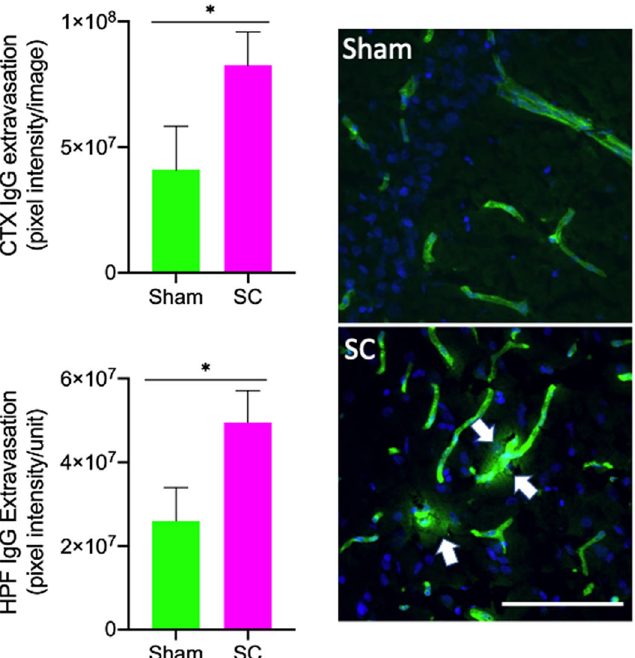
Figure 3. BBB permeability. The integrity of BBB was assessed with immunofluorescent microscopy measuring the parenchymal perivascular extravasation of IgG in rats that received either sham or repeated sub-concussion (SC) procedure for 2 weeks. The IgG extravasation was semi-quantitatively determined in the cortex (CTX) and hippocampal formation (HPF) regions and expressed pixel intensity per image (mean ± SEM, left frame). Representative immunomicroscopy images are presented on the right with IgG shown in green and perivascular leakage indicated with white arrows (scale bar = 100 µm). Statistical significance was determined with t-test (* p < 0.05, n = 8).